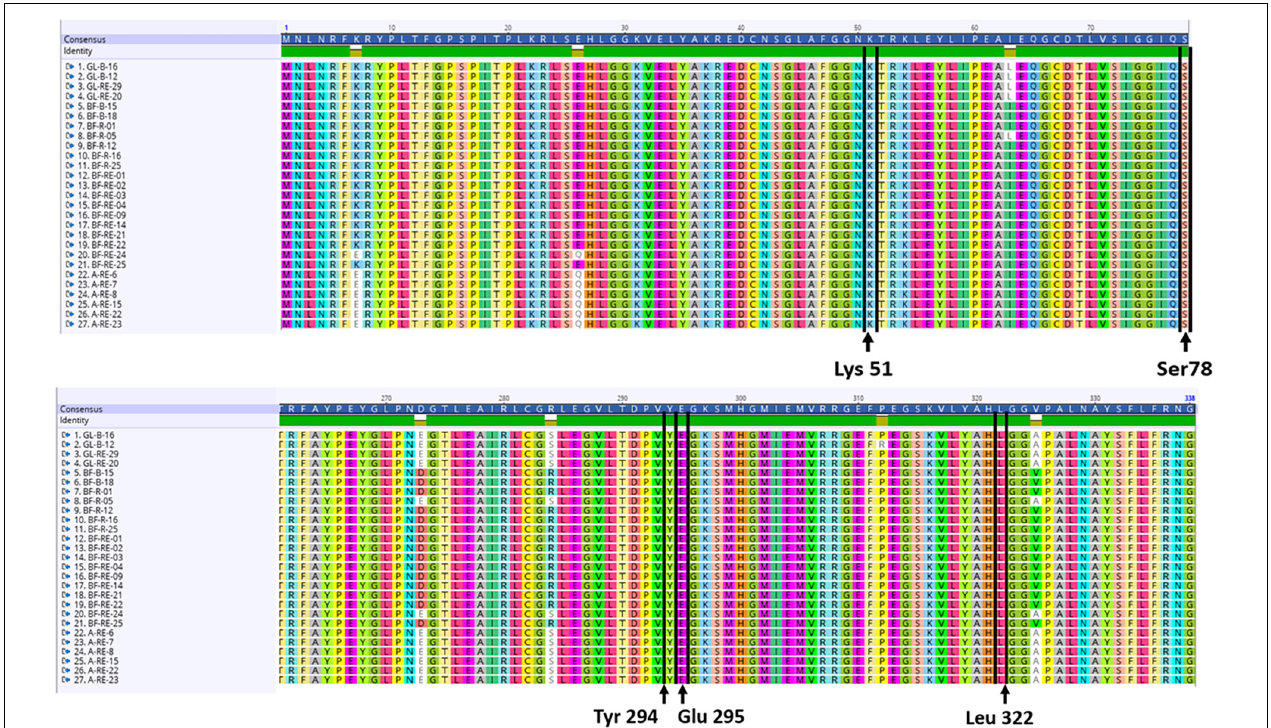
FIGURE 5 | In silico analysis of the acdS translated amino acid sequences. The amino acids Lys51, Ser78, Tyr294, Glu295, and Leu322 have all been implicated as essential for the functioning of the acdS gene in the reference isolate Pseudomonas sp. UW4. The alignments shown here with amino acid sequences translated from the acdS gene were each found to have all 5 amino acids in the same position as the reference isolate Pseudomonas sp.